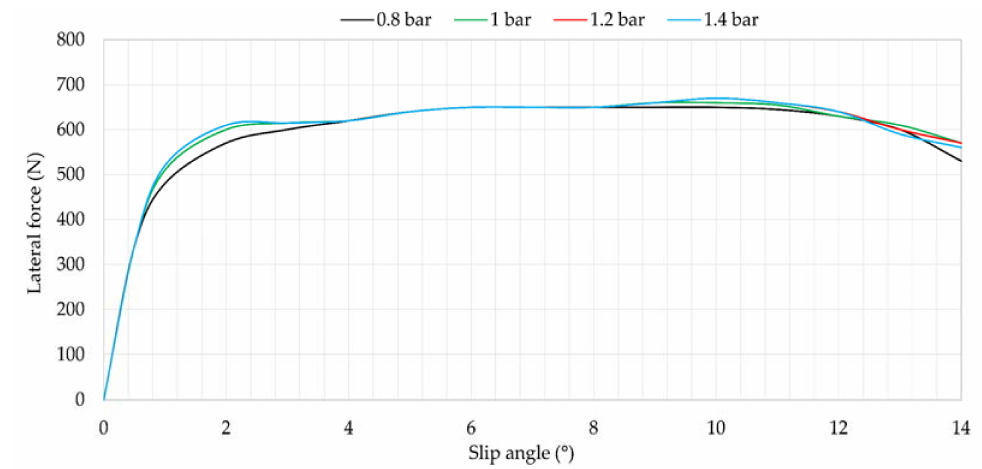
Figure 10. Influence of inflation pressure at 750 N, 50 km/h.